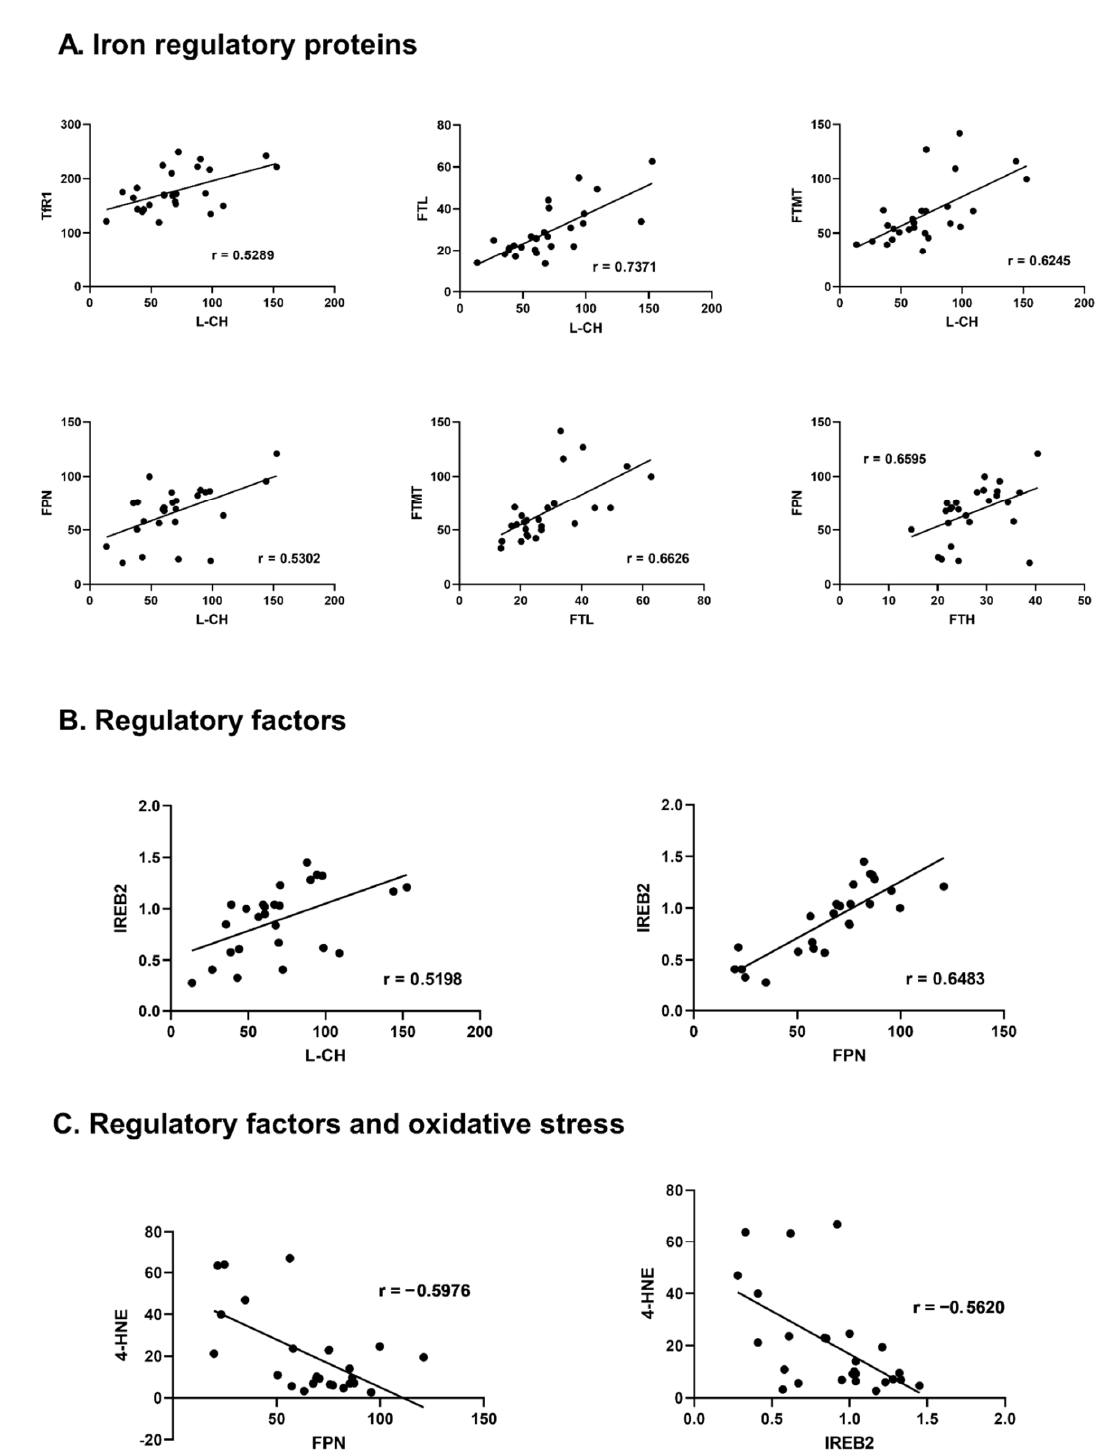
Figure 2. Correlations between iron-handling proteins, regulatory factors and oxidative stress markers in the non-failing human myocardium. ( A )—Iron regulatory proteins, ( B )—regulatory factors, ( C )—Regulatory factors and oxidative stress. Only significant, highly-correlated proteins (r > 0.5, p < 0.05) are shown, all correlations are presented in the supplement (Table S6); r—Pearson correlation coefficient. Aberrations: L-CH (L-type calcium channel Subunit CACNa1D), TfR-1 (transferrin receptor -1), FT-H (ferritin heavy chain), FT-L (ferritin light chain), FT-MT (ferritin- mitochondrial), FPN (ferroportin), IREB-2 (iron response protein-2), HIF-1 (hypoxia-induced factor), 4-HNE